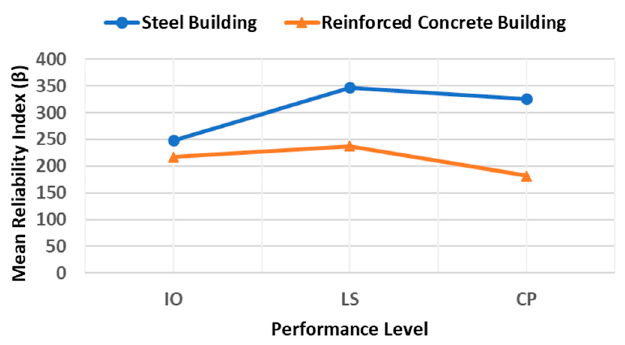
Figure 13. Mean reliability index for steel and reinforced concrete buildings located at Ciudad Victoria, Tamaulipas (seismic zone A).